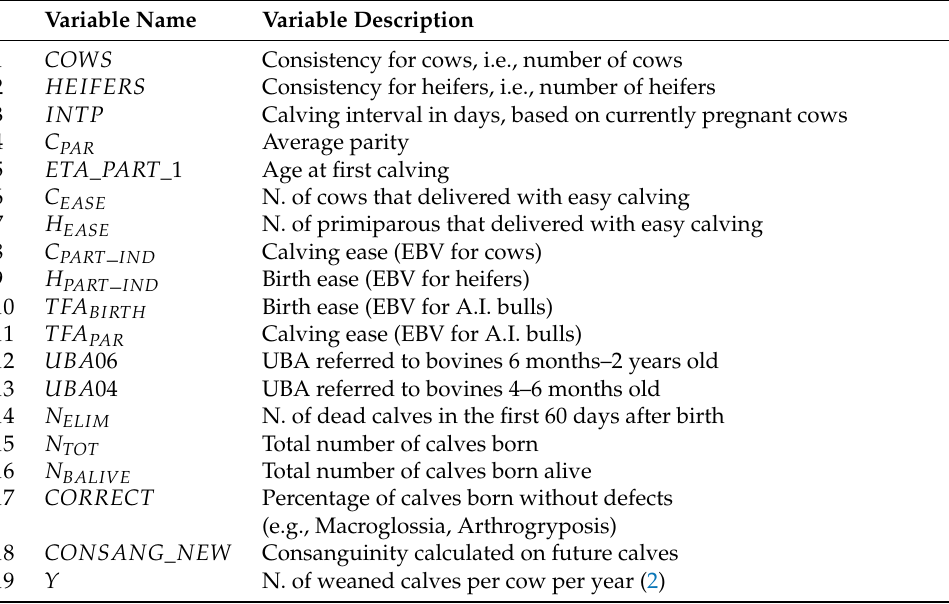
Table 2. Final set of variables used for the benchmarked problem. The bottom line represents the dependent variable Y , i.e., the target for the predicted